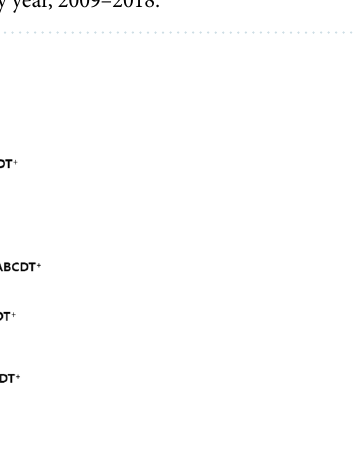
Figure 2. Distribution of ( A ) sequence types (ST) and ( B ) clades by year, 2009–2018.